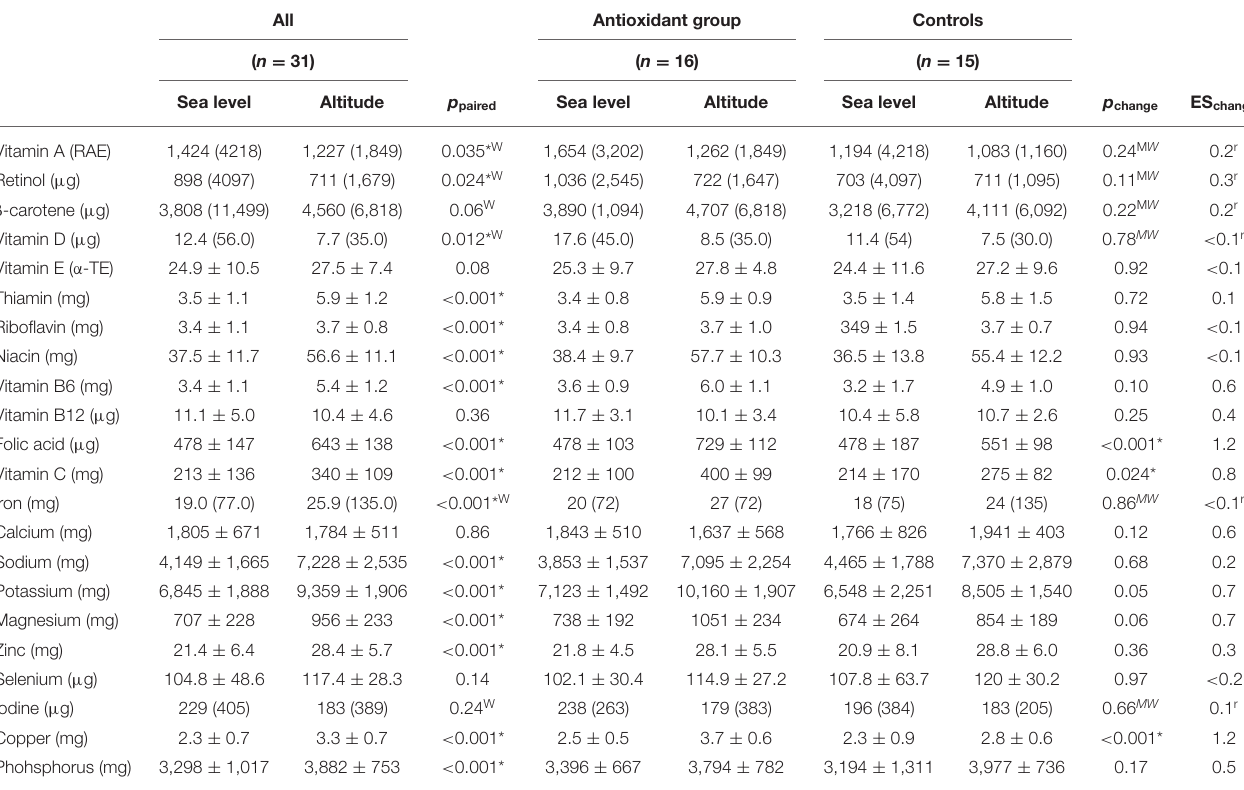
TABLE 4 | Mean daily micronutrient intake before (Sea level) and during (Altitude) the 3-week training camp at 2,320m. All Antioxidant group Controls ( n = 31) ( n = 16) ( n = 15) Sea level Altitude p paired Sea level Altitude Sea level Altitude p change ES